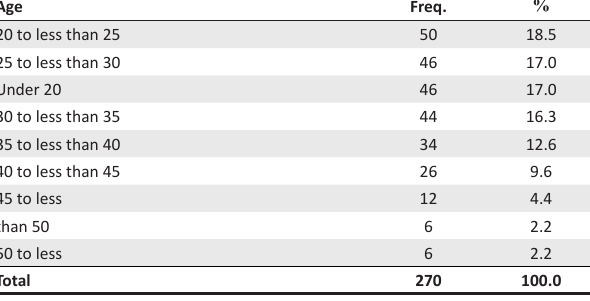
TABLE 1e: Background of respondents.